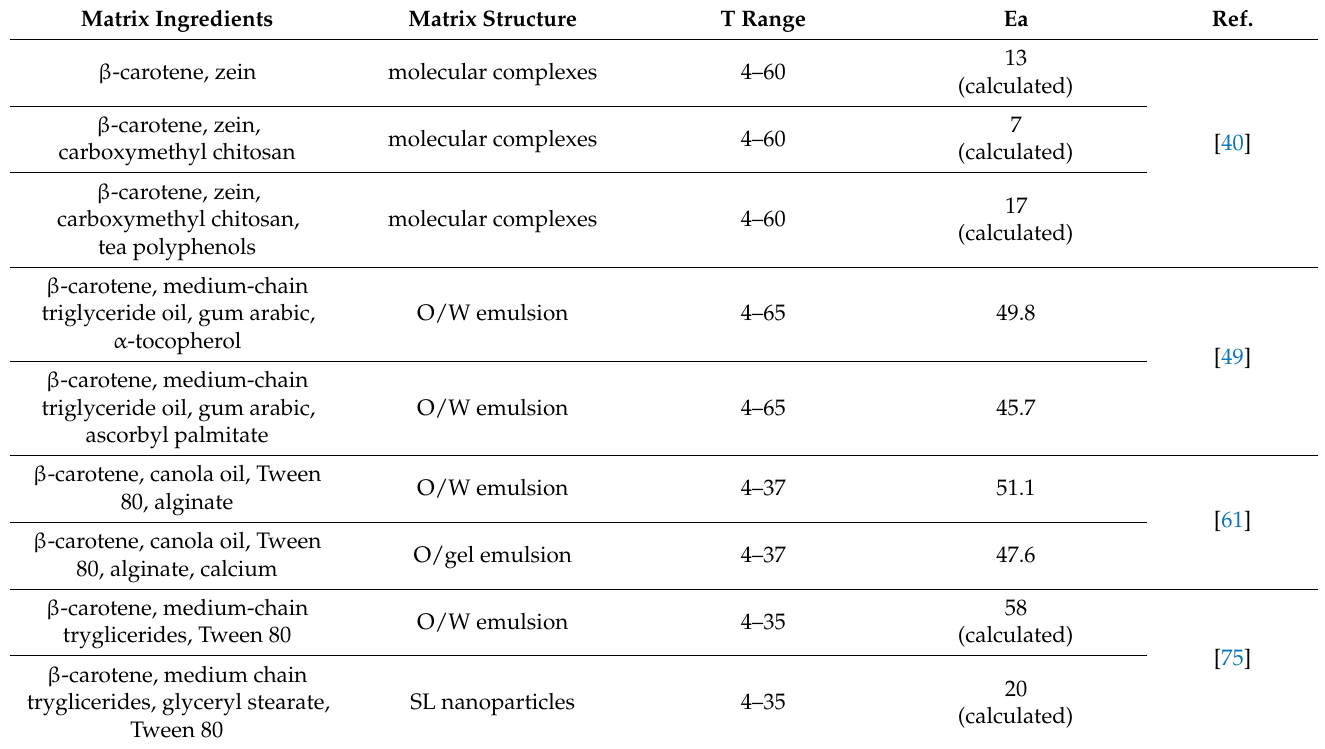
Table 3. Activation energy (Ea, kJ/mol) in a given temperature range (T range, ◦ C) for the degradation of β -carotene encapsulated in nano-and micro-structures in aqueous environments.